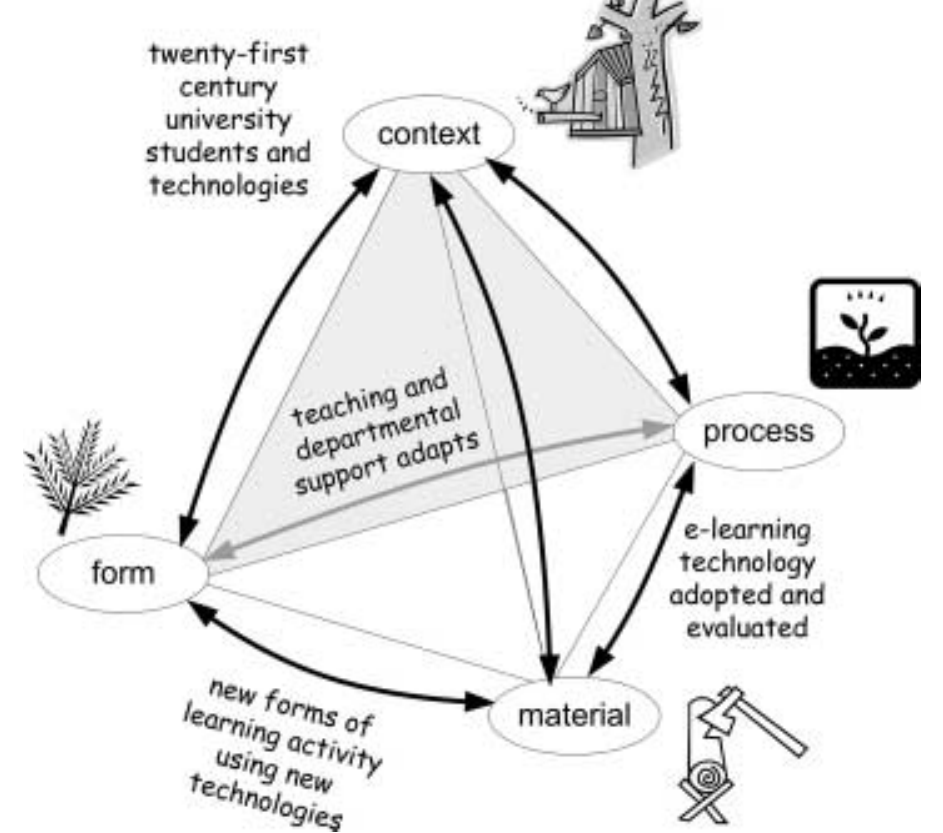
Figure 1. A conceptual framework for modelling university learning and teaching systems, including the role of material technologies. Capra (2002) suggests that complex adaptive systems theory is not just a biologi-